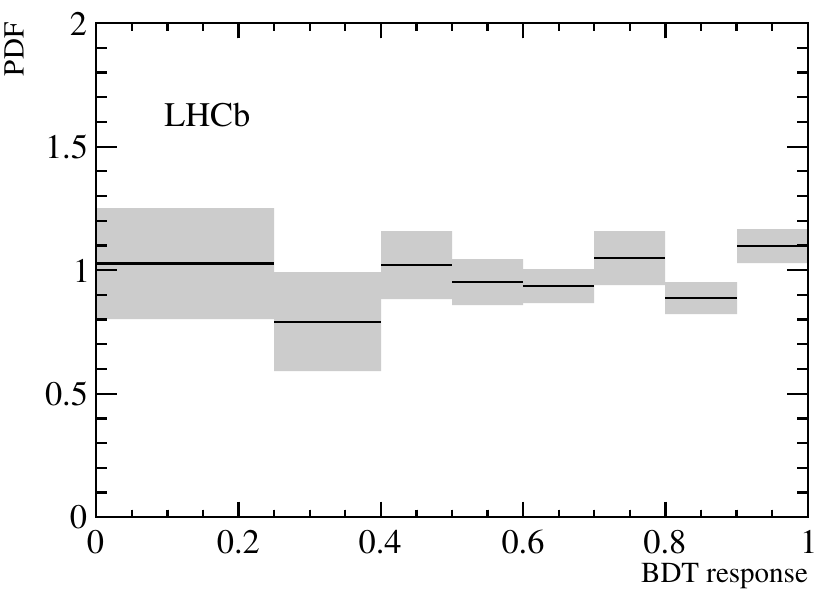
! e (cid:6) (cid:22) (cid:7) decays with recovered ( s )